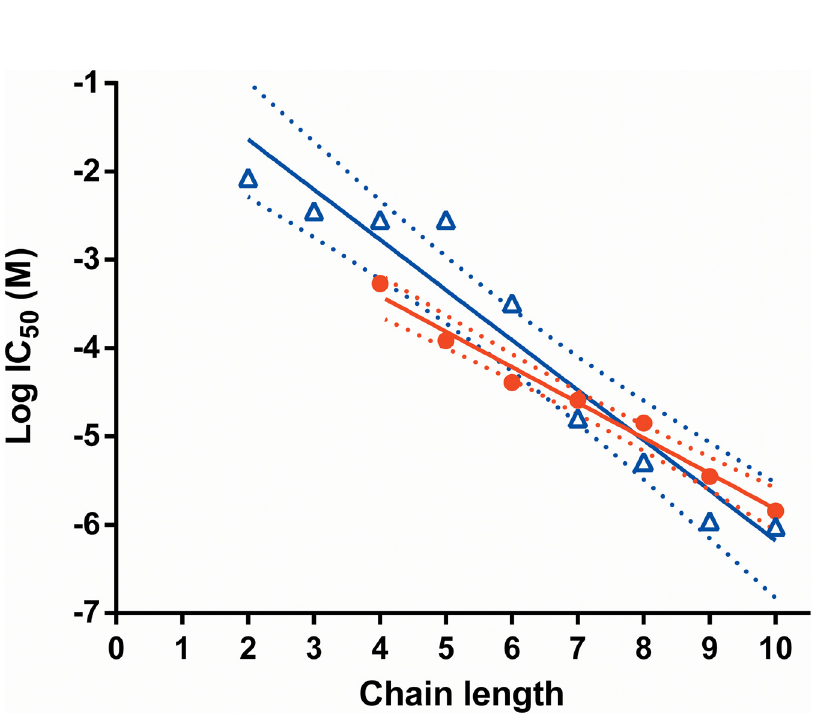
Fig 7. Relationship between polymethylene linker chain length and log IC 50 . Data are shown for CN21 (open blue triangles) and SH-SY5Y (closed red circles) cells. Solid lines show linear regression fits of the data for the two data sets: CN21, y = -0.575x - 0.450, r 2 = 0.936; SHSY5Y, y = -0.402x - 1.799, r 2 = 0.980. Broken lines show the 95% confidence intervals of the fits.